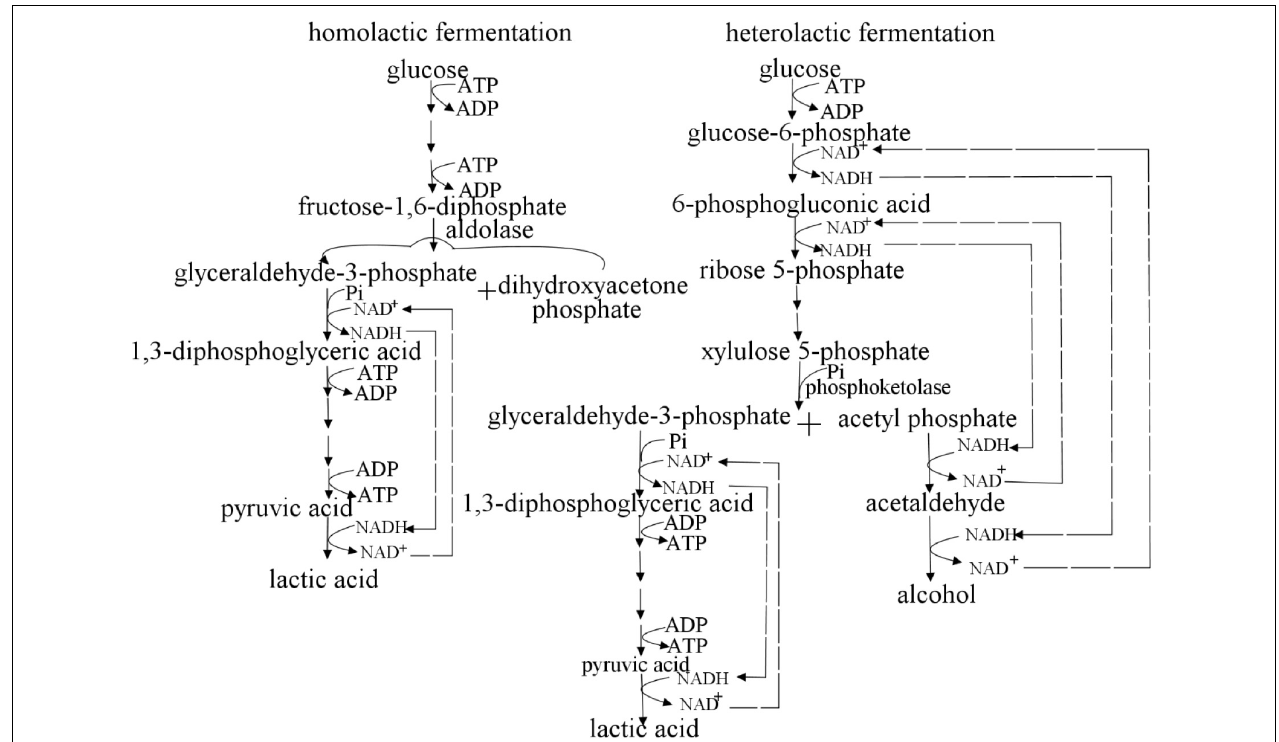
FIGURE 2 | Homolactic fermentation and heterolactic fermentation. Lactococcus spp. performs homolactic fermentation, while Lactobacillus and Leuconostoc spp. perform heterolactic fermentation. (1) In the process of pure lactic acid fermentation, lactic acid bacteria use glucose as a carbon source to produce pyruvate through glycolysis, and then produce lactic acid under the action of lactate dehydrogenase. In theory, 1 mole of glucose produces 2 moles of lactic acid. (2) In lactic acid bacteria of the heterolactic fermentation type, glucose can be decomposed into lactic acid, ethanol, CO 2 (in Leuconostoc , etc.) through the phosphoketolase (PK) pathway. In theory, 1 mole of glucose produces 1 mole of lactic acid. (3) Through the pentose phosphate (PP) pathway, glucose 6-phosphate was converted into carbon dioxide, ribulose 5-phosphate and NADPH (Eiteman and Ramalingam, 2015; Stincone et al.,